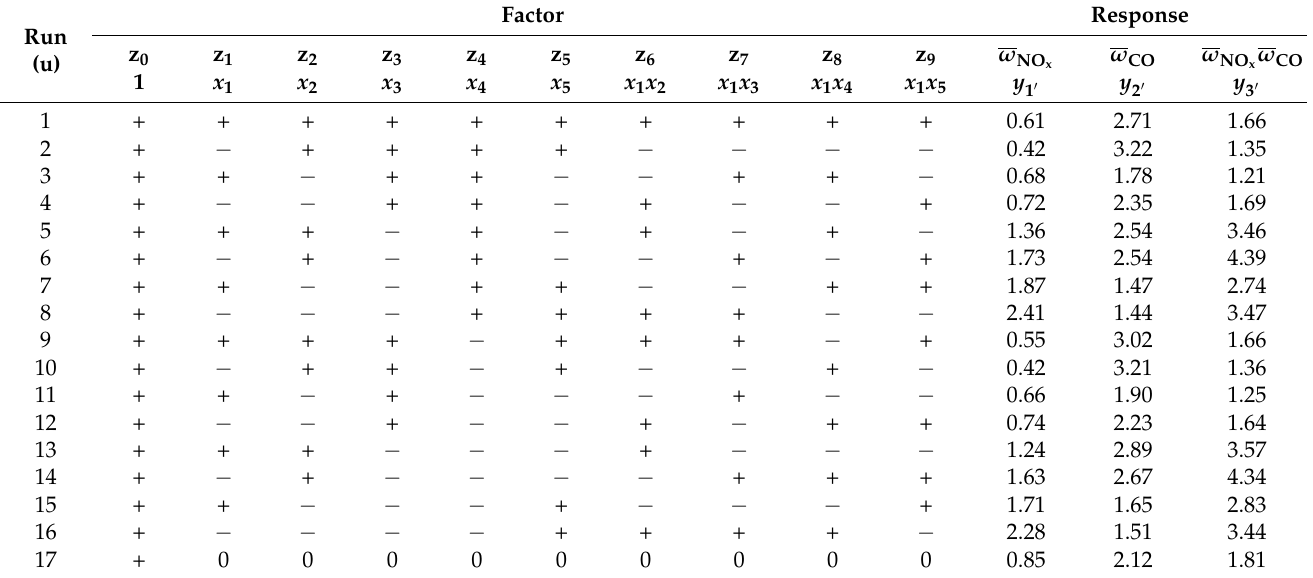
Table 5. Fractional factorial design and experimental results involving five